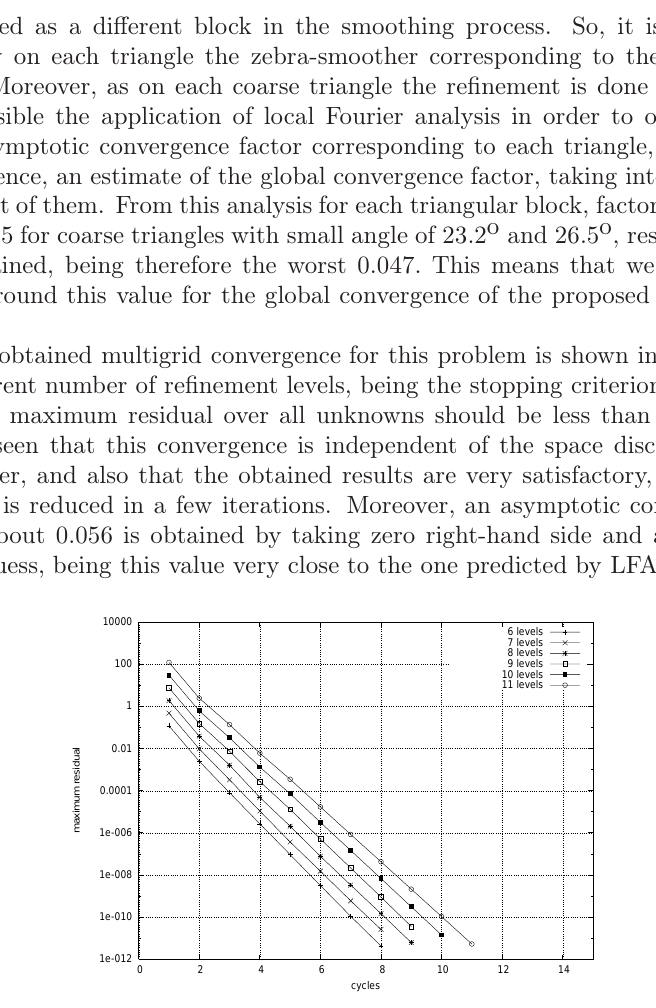
Figure 8. Multigrid convergence for model problem (3.1) with V(0,2) using a zebra-type smoother, for the first numerical